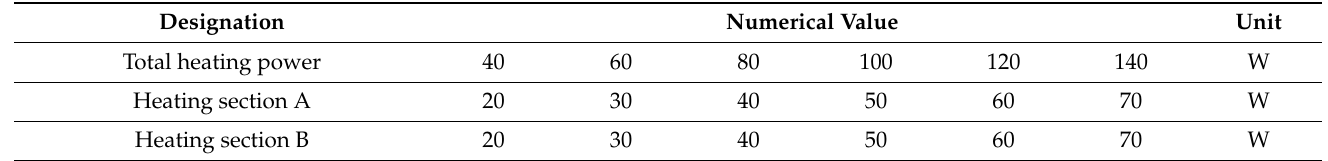
Table 3. Heating power configuration of heating section A and B under the condition of homogeneous heat flux.